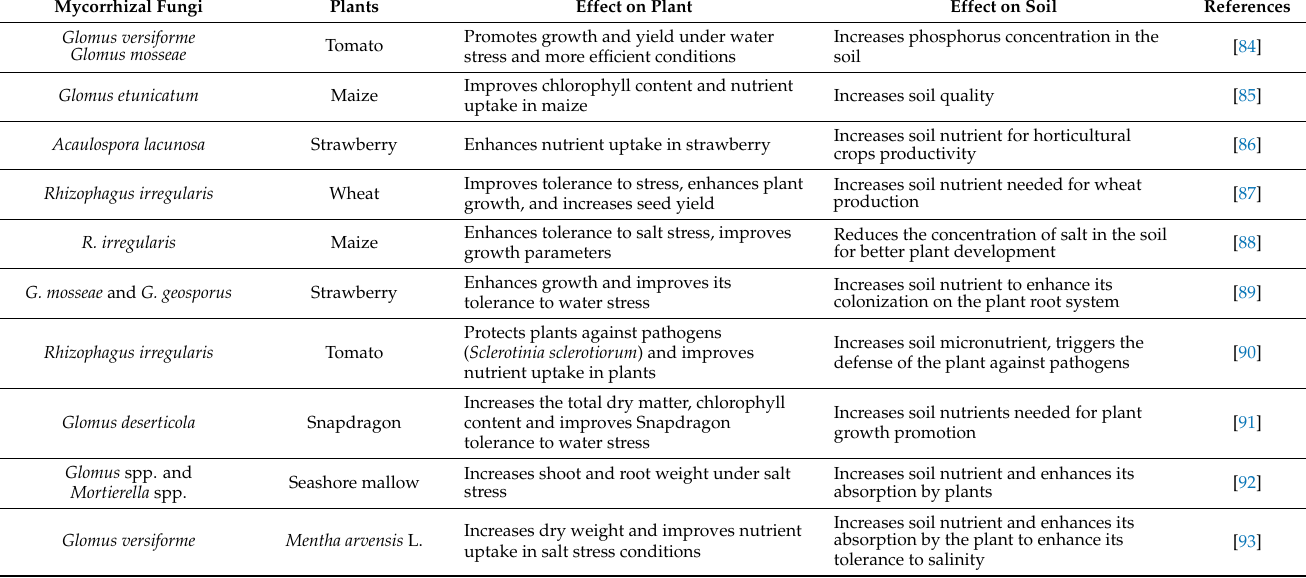
Table 2. Contribution of arbuscular mycorrhizal fungi to plant growth promotion and soil